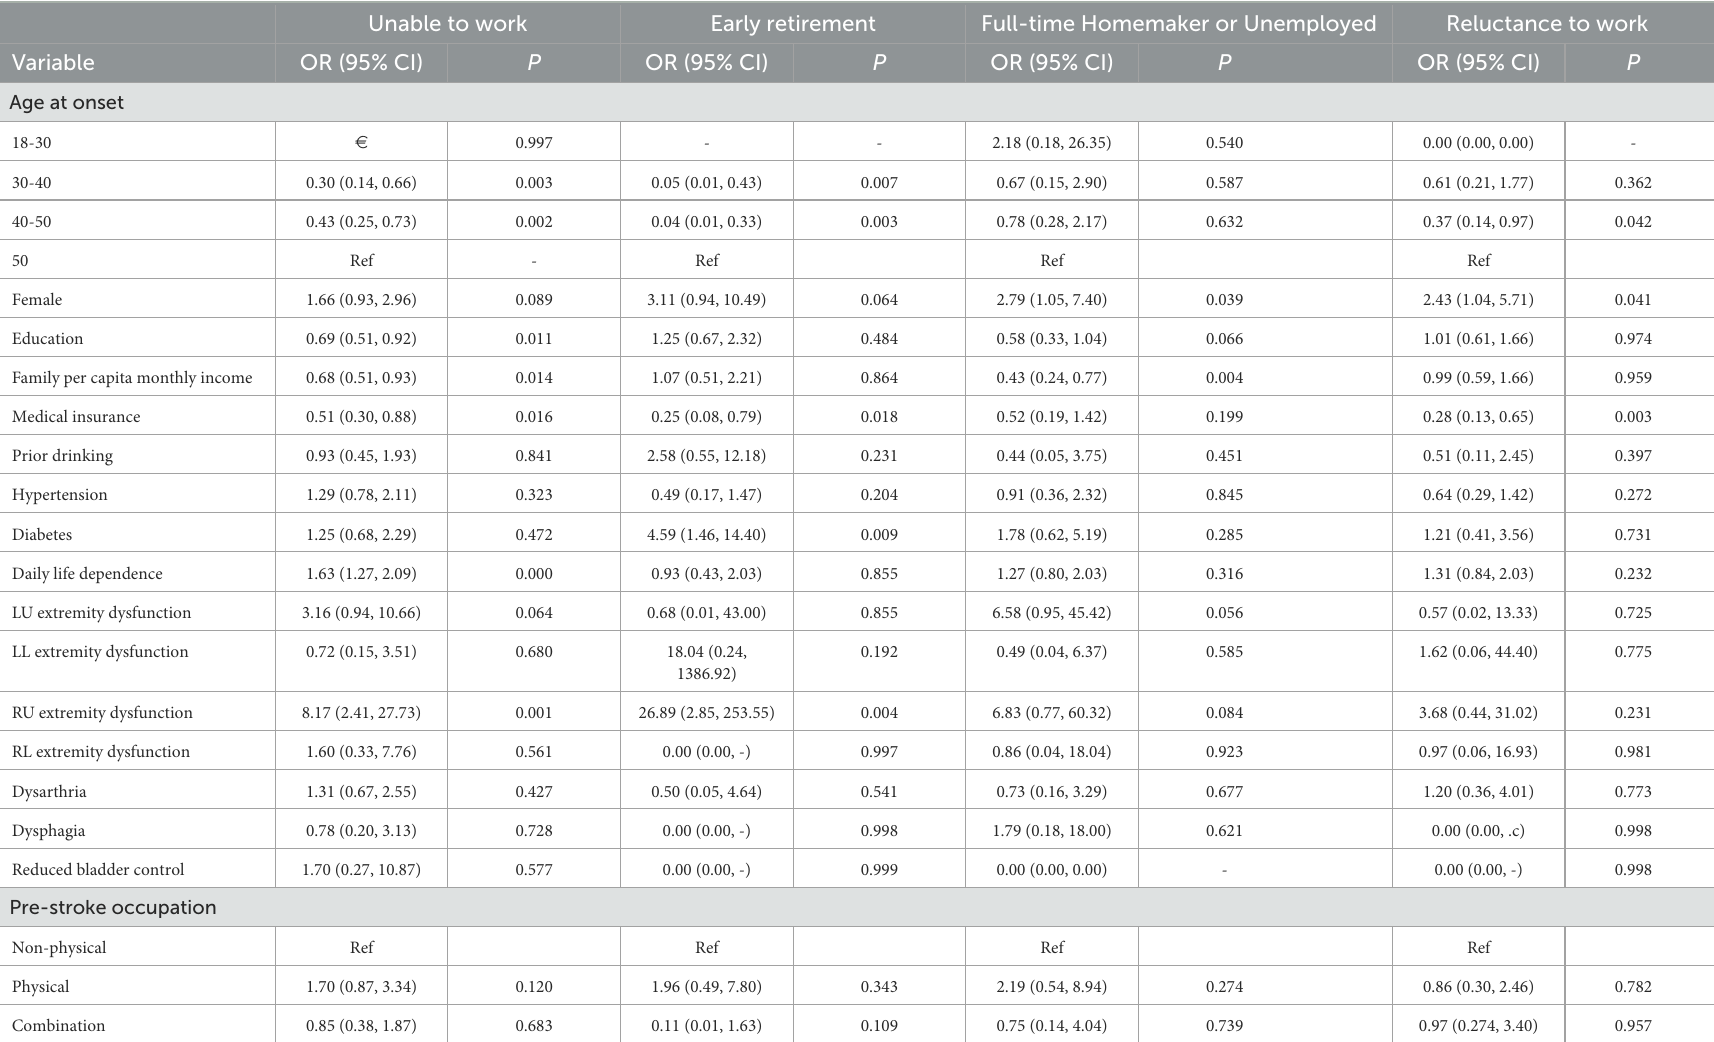
TABLE 3 Factors of reasons for non-RTW: Multinomial logistic regression (vs.